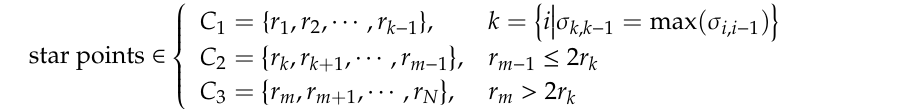
W=13 t Figure 5. Star images matching. 2.4. Rapid Elimination of Fake Stars Most existing star identification algorithms construct features in a single frame through angular distance between stars or geometric distribution of stars, then find corresponding matching stars in the navigation star database. The amount of navigation star database is huge. When the number of fake star points is too large, the matching search time will increase non-linearly and sharply, and a large number of mismatches will occur. In two consecutive frames of star images, the angle between any two true star vectors is constant, while the angle between fake stars is probable not because of their fast and irregular movement.